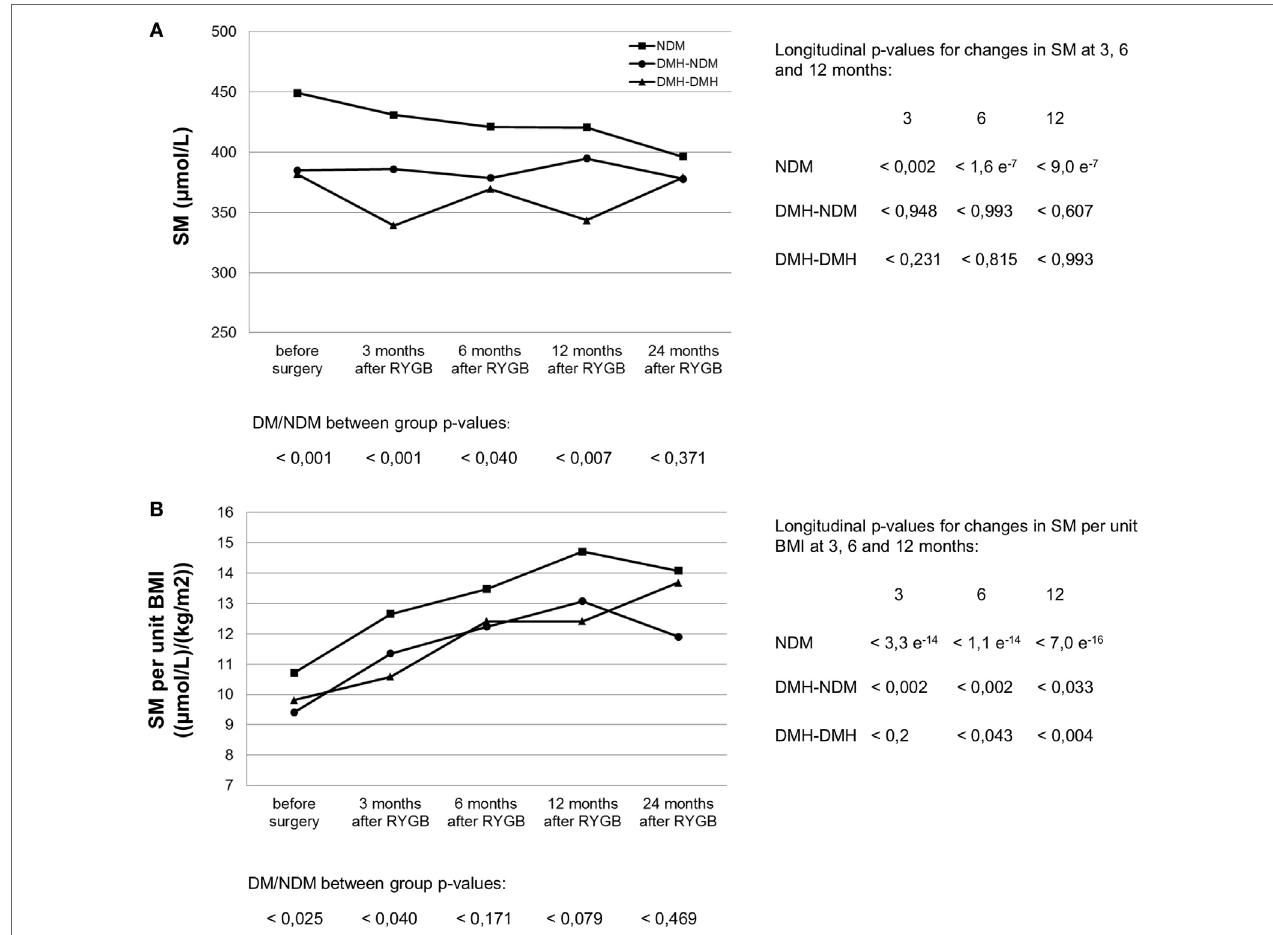
FigUre 1 | Serum sphingomyelin (SM) concentration (a) and its relation to body mass index (B) before and after RYGB surgery in non-diabetic and diabetic patient subgroups. NDM, patients without diabetes mellitus (DM); DMH-NDM, patients with DM in remission after RYGB; DMH-DMH, patients with DM not in remission after RYGB. Examples are from the female subpopulation. Male subpopulation showed similar trend, as seen in Table S2 in Supplementary Material. The curves for SM per kilogram bodyweight were similar to the ones per unit BMI shown in (B) . p -Values from independent samples t -tests comparing patients with diabetes (DM) with patients without diabetes (NDM) at each time point are shown at the bottom of each figure. No statistical significance was found between the two diabetic subgroups. Longitudinal p -values from paired t -tests comparing postoperative SM at 3, 6, and 12 months after surgery with corresponding values before surgery are shown in columns to the right of the